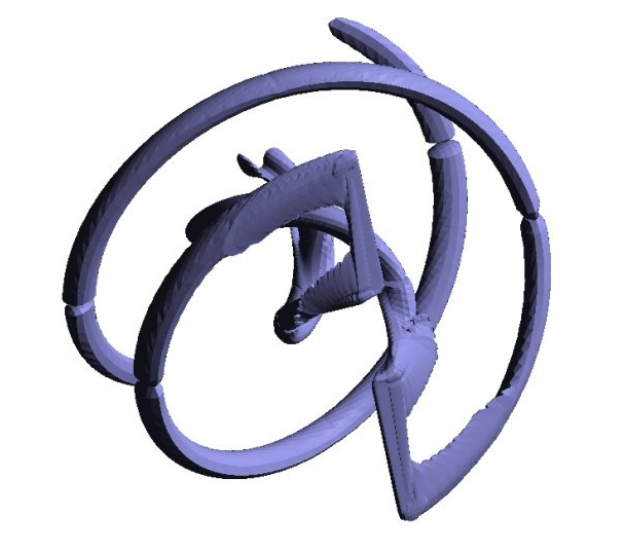
Figure 2. Isosurfaces of vorticity for the NREL Phase VI rotor using an actuator surface model